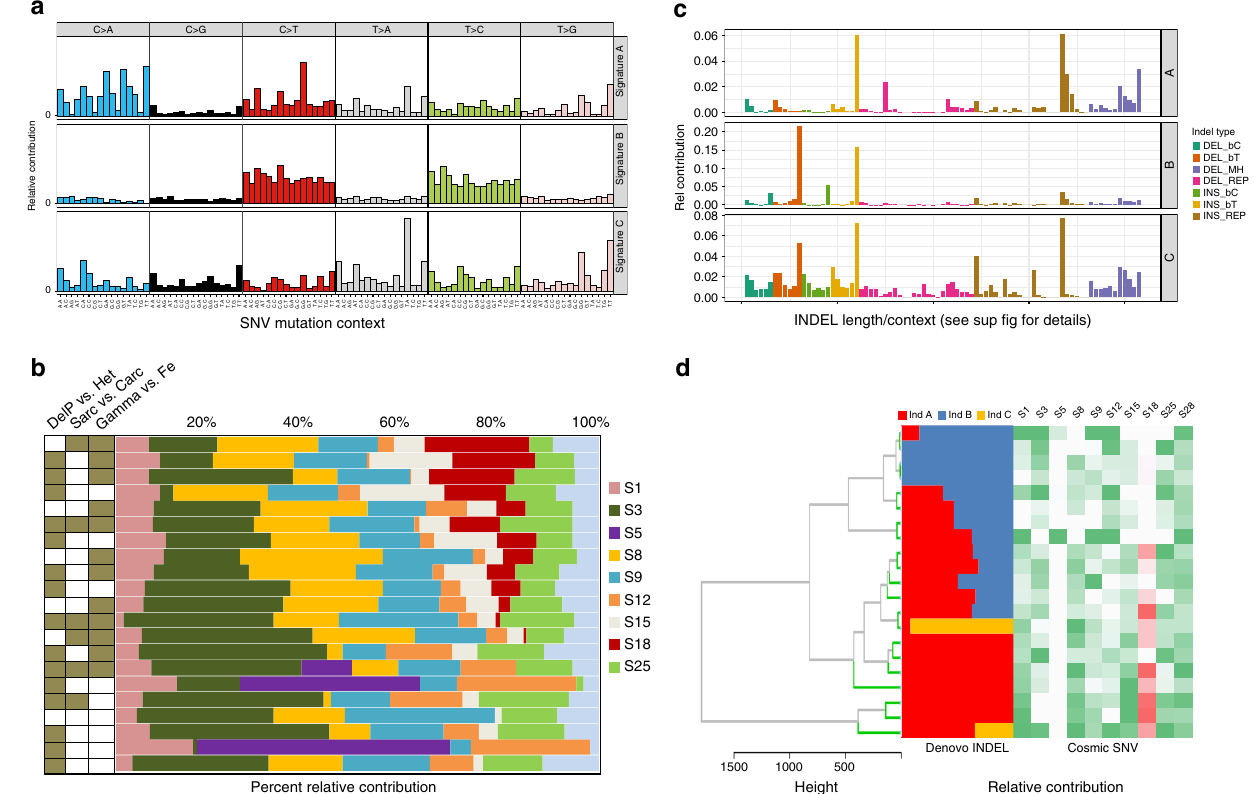
Fig. 2 SNV and INDEL signatures in RT-induced mammary tumours. a De novo SNV signature extraction using NMF identi fi ed three distinct point mutation signatures, referenced to here and in the text as “ A ” , “ B ” and “ C ” . N = 21. b Deconvolution of the mutation signatures into known Cosmic signatures found in human tumours. Samples are denoted by radiation quality, tumour pathology and Trp53 genotype. DelP (Brown) = P53 Delta Proline ( Trp53 Δ P ); Het = P53 Heterozygous (White), Sarcoma (Brown), Carcinoma (White), Gamma (Brown) and Fe (White). The red blocks represent the contribution of the signature 18 “ ROS ” to total mutations in each sample, and these are relatively enriched in tumours induced by gamma radiation compared to 56 Fe ions ( P < 0.032). Pale blue denotes contribution from variants not explained by known Cosmic signatures. N = 21. c Relative contribution of each insertion/deletion mutation type in the three INDEL signatures identi fi ed in the mammary tumour samples. See Supplementary Fig. 2 for a breakdown of all categories of INDEL types. “ Del_B ” = 1 bp deletion, “ Ins_B ” = 1 bp insertion, where “ C ” or “ T ” describes whether cytosine or thymidine was deleted at that position, “ MH ” = microhomology domain and “ REP ” = >1 bp deletion or insertion at repeats. N = 21. d Relationship between INDEL signatures and SNV signatures. Hierarchical clustering of both INDEL signatures and SNV signatures demonstrates an enrichment of de novo INDEL signature A (left) and SNV signature 18 (ROS, right) in samples induced by exposure to gamma radiation compared to those induced by 56 Fe ions ( P < 0.032). N =